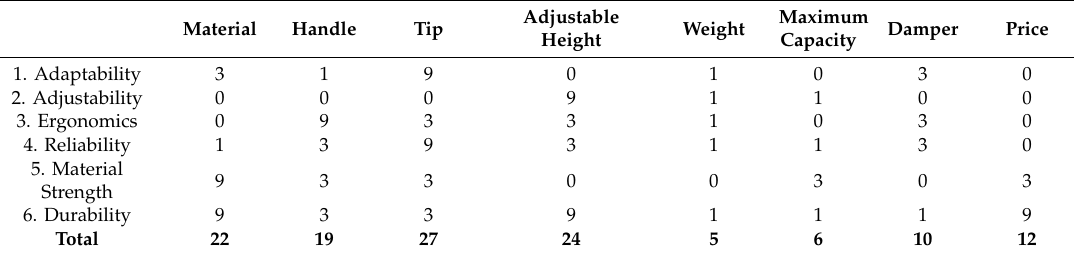
Table 5. What-How